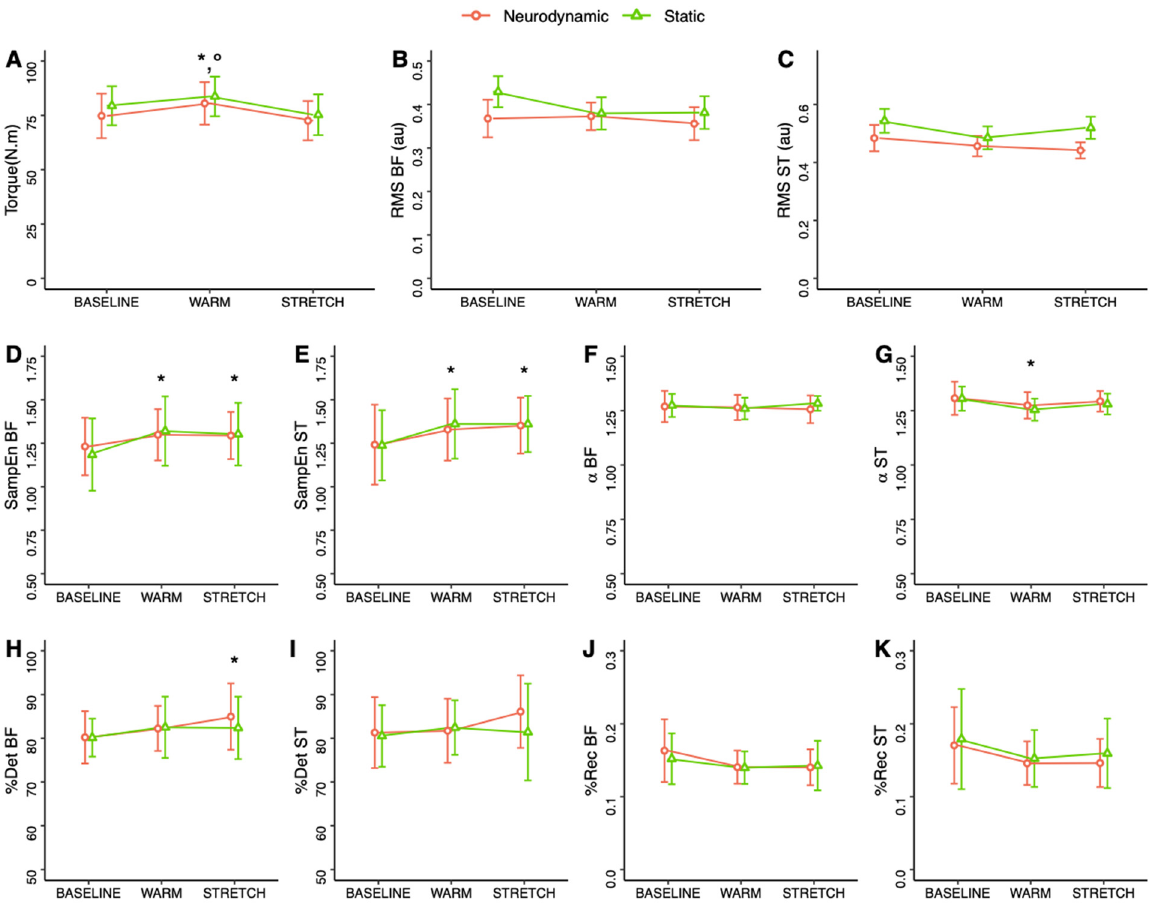
Figure 4. Torque ( A ), root mean square (RMS; ( B , C )), sample entropy (SampEn; ( D , E ), a scaling parameter ( F , G ), percentage of recurrence and determinism (%Rec and %Det; ( H – K )) for biceps femoris and semitendinosus muscles (BF and ST, respectively) during maximal voluntary contractions. Values are mean ± standard deviation. *: significant difference with respect to BASELINE, °: significant difference with STRETCH ( p < 0.05).